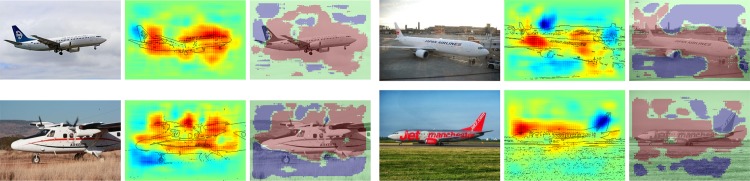
Pixel-wise decomposition for Bag of Words features over a histogram intersection kernel using the layer-wise relevance propagation for all subsequent layers and rank-mapping for mapping local features.Each triplet of images shows—from left to right—the original image, the pixel-wise predictions superimposed with prominent edges from the input image and the original image superimposed with binarized pixel-wise predictions. The decompositions were computed on the whole image. Notably the tail of a plane receives negative scores consistently. Blue sky context seems to contribute to classification which has been conjectured already in the PASCAL VOC workshops [35] and which was observed also on other images not shown here, see the the second picture for comparison against the other three images which have more blueish sky. Images from Pixabay users Holgi, nguyentuanhung, rhodes8043 and tpsdave.